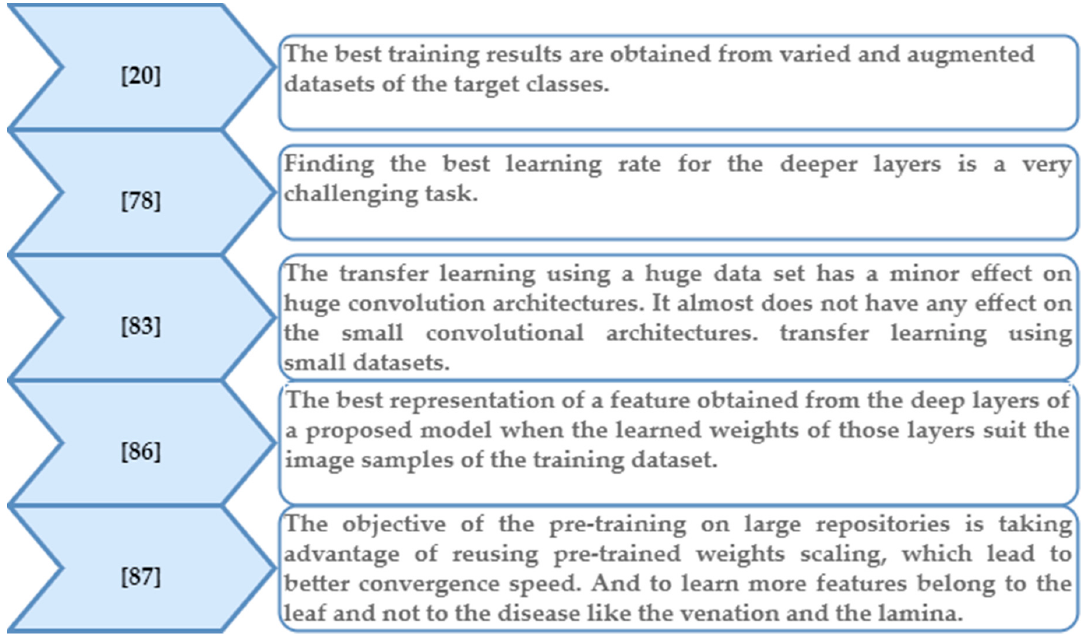
Figure 5. Basic findings regarding transfer learning [20,78,83,86,87].